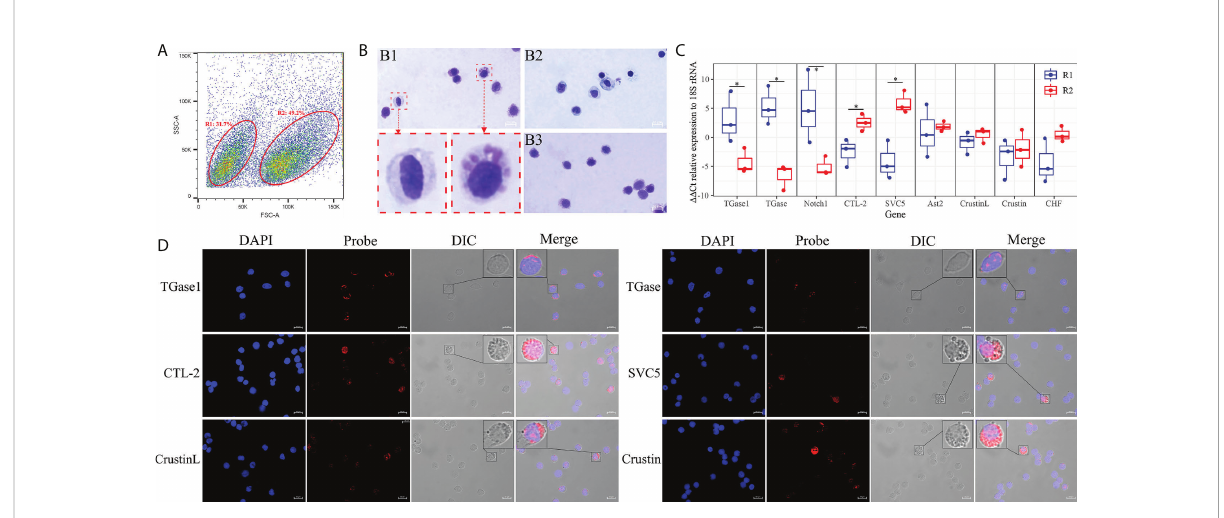
FIGURE 6 Morphological analysis of hemocytes clusters. (A) FACS analysis of hemocytes. Based on the FSC and SSC, two regions (R1 and R2) were sorted, respectively. (B) Hemocytes and cell subpopulations were stained by May-Grunwald and Giemsa dye. B1: hemocytes. B2: R1 sorted hemocytes. B3: R2 sorted hemocytes. (C) Differential expression analysis of highly speci fi c cell clusters gene between R1 and R2 of hemocytes sorted using FACS. (D) Validation of the highly speci fi c cell clusters gene among hemocyte subpopulations by FISH. The asterisks on the bars represent the statistical difference of the hemocyte